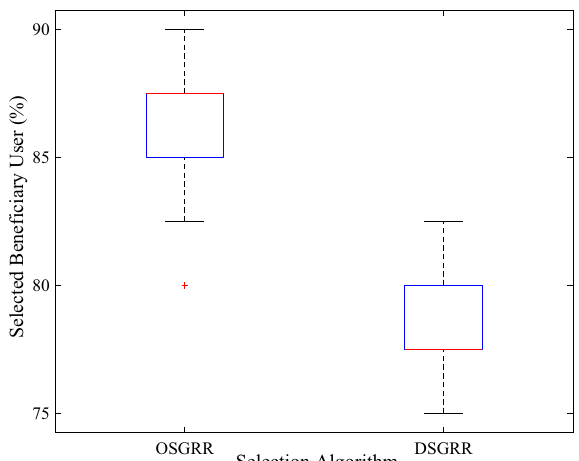
Fig. 15 Comparison of the average number of selected beneficiary users between the DSGRR and OSGRR